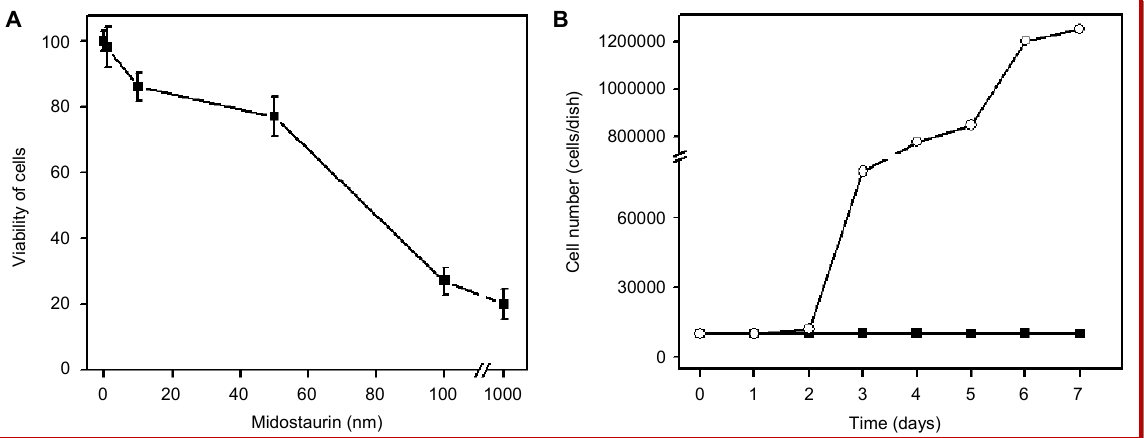
Figure 1: A. Concentration-dependent effect of midostaurin on DU145 cells proliferation. Cells were treated with midostaurin for 72 hours. Viable cells are calculated as per the standard protocol. T. B. Midostaurin effect on proliferation of DU145 cells. The val- ues given are mean ± SD of three independent experiments